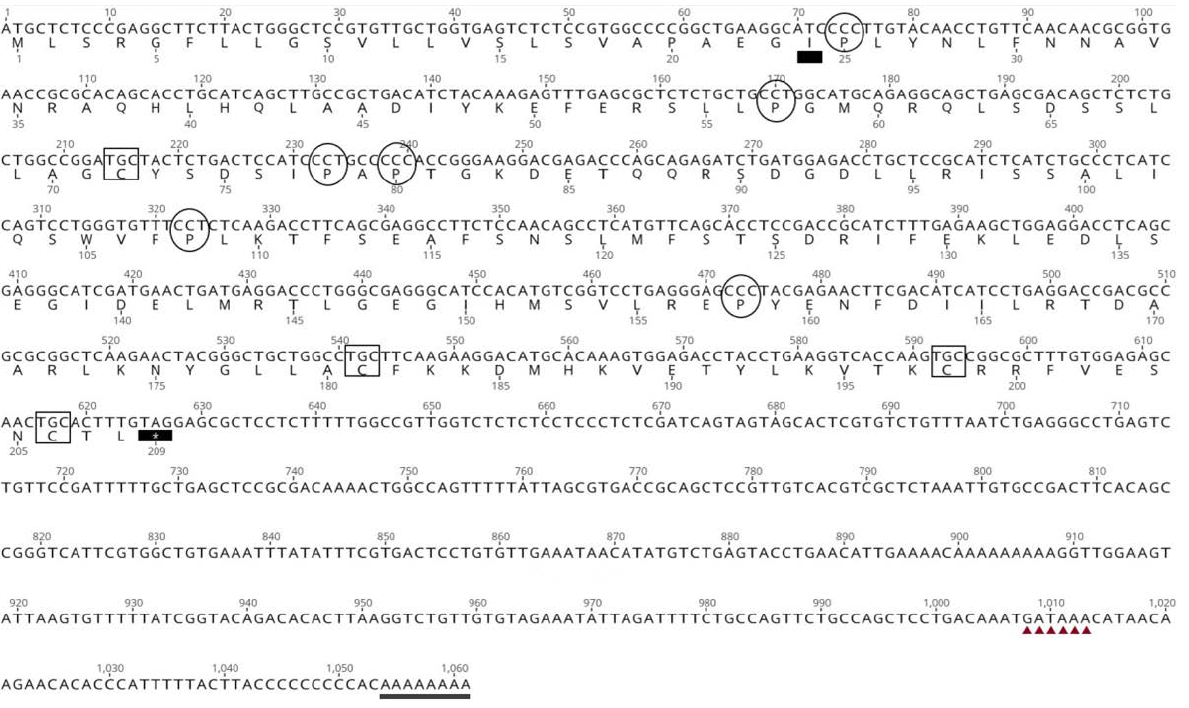
Figure 2. Arapaima gigas growth hormone cDNA and amino acid sequence. Signal peptide prediction indicates the presence of a cleavage site between residues 23 and 24. A black rectangle indicates the first amino acid of the mature peptide (I) and the asterisk is the stop codon; C, inside a square, indicates the cysteines involved in disulfide bridges; and P, inside a circle, indicates proline residues. Triangles indicate the poly-A signal (GATAAA) followed by the poly-A tail. GenBank accession number OP573508.